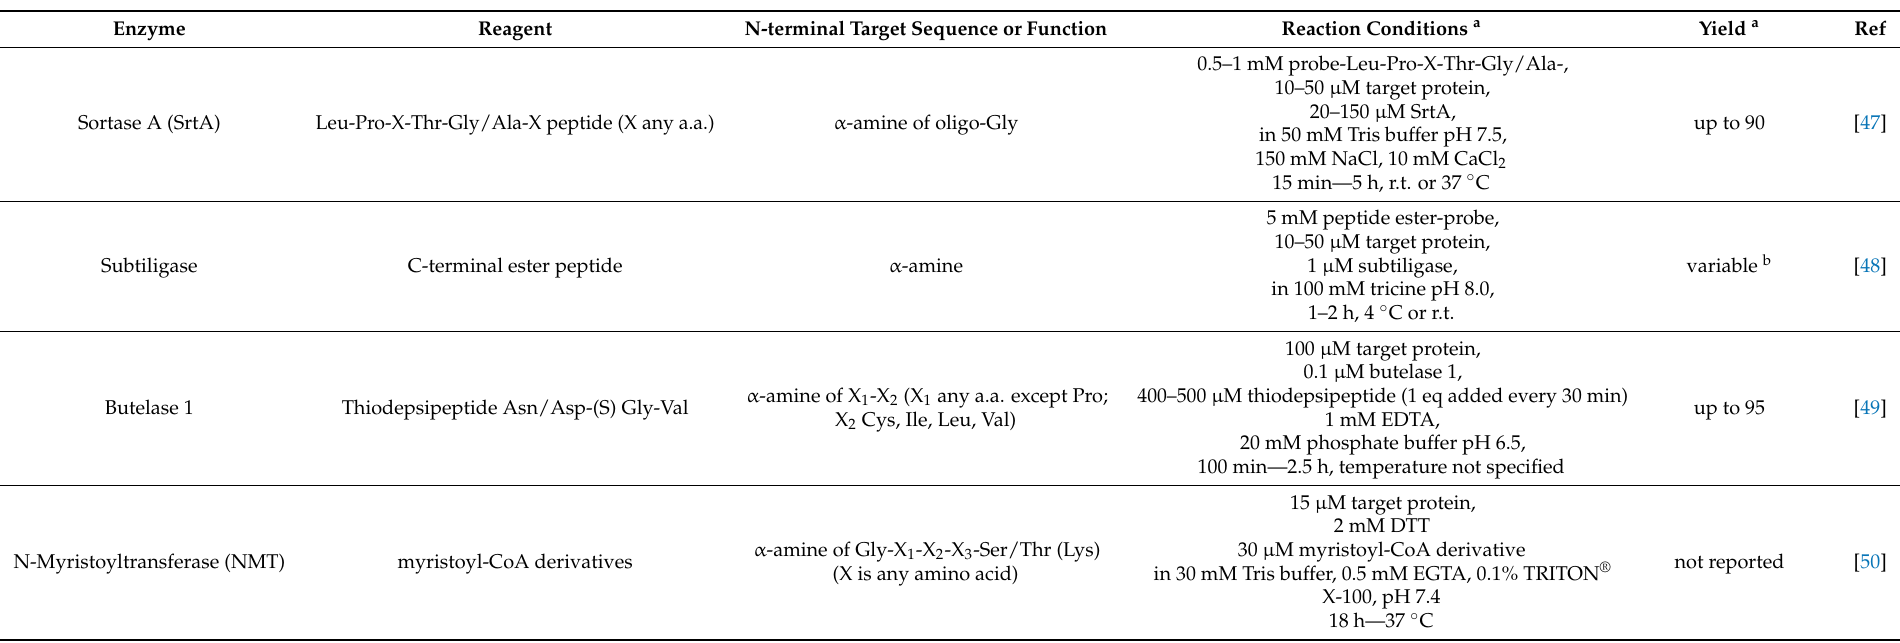
Table 2. Enzyme-catalyzed strategies for site-specific N-terminal protein